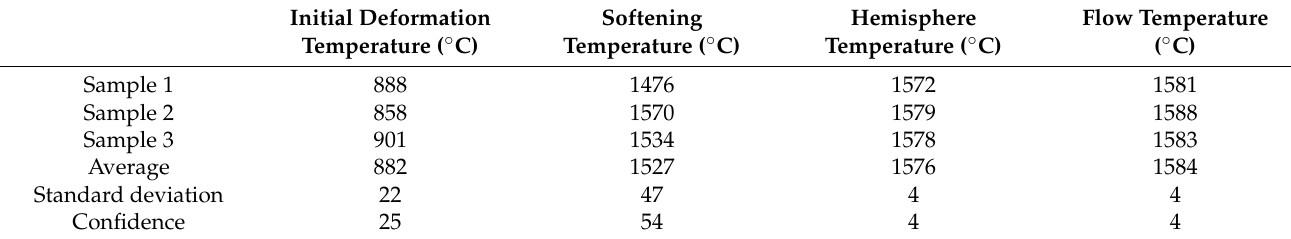
Table 6. Ash fusibility temperature analysis: initial deformation temperature, softening temperature, hemisphere tempera- ture, and flow